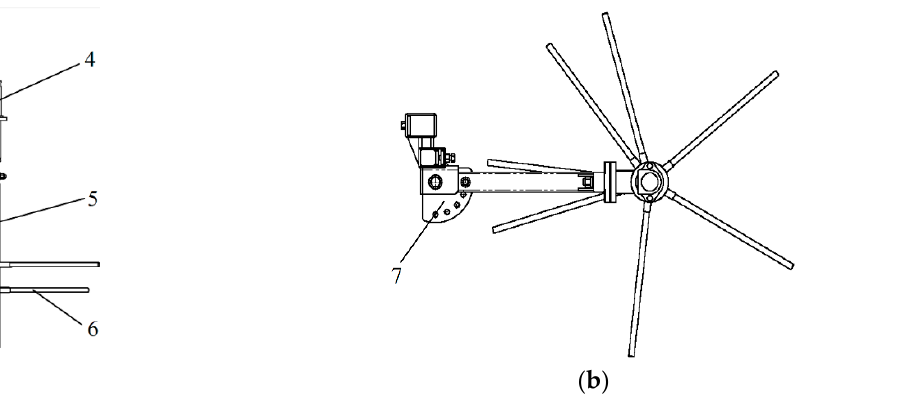
Figure 5. Schematic diagrams of removal mechanism for jujube hangings. (1) Vertical beam. (2) Fixed connection seat. (3) Crossbeam. (4) Hydraulic motor. (5) Roller. (6) Dial rod. (7) Angle regulator. ( a ) Main view. ( b ) Top view.